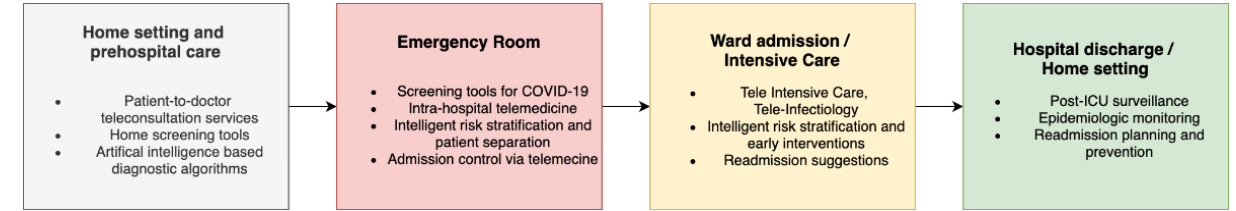
Figure 1. Levels of telemedical interventions during the COVID-19 crisis. COVID-19: coronavirus disease; ICU: intensive care